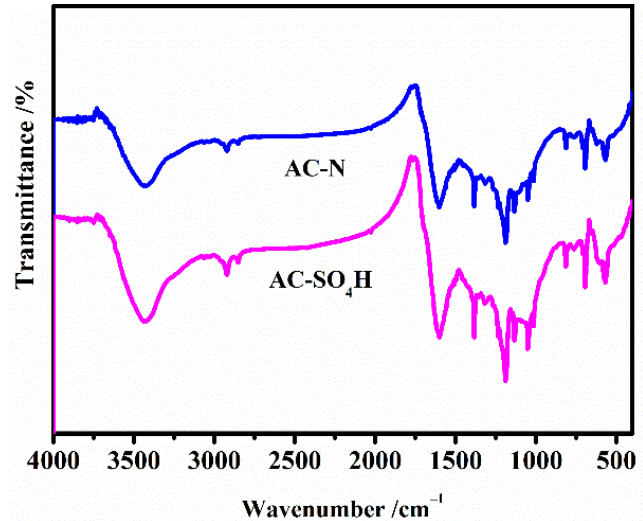
Figure 5. FT-IR spectrum of AC-N-SO 4 H and AC-N.